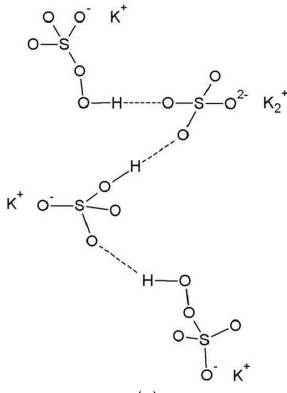
Figure 3. Chemical structure of ( a ) glutaraldehyde (GA), ( b,c ) quaternary ammonium compounds (QUATs), ( d) alkyl amine, and ( e ) pentapotassium bis(peroxymonosulfate) bis(sulfate) (MPS).